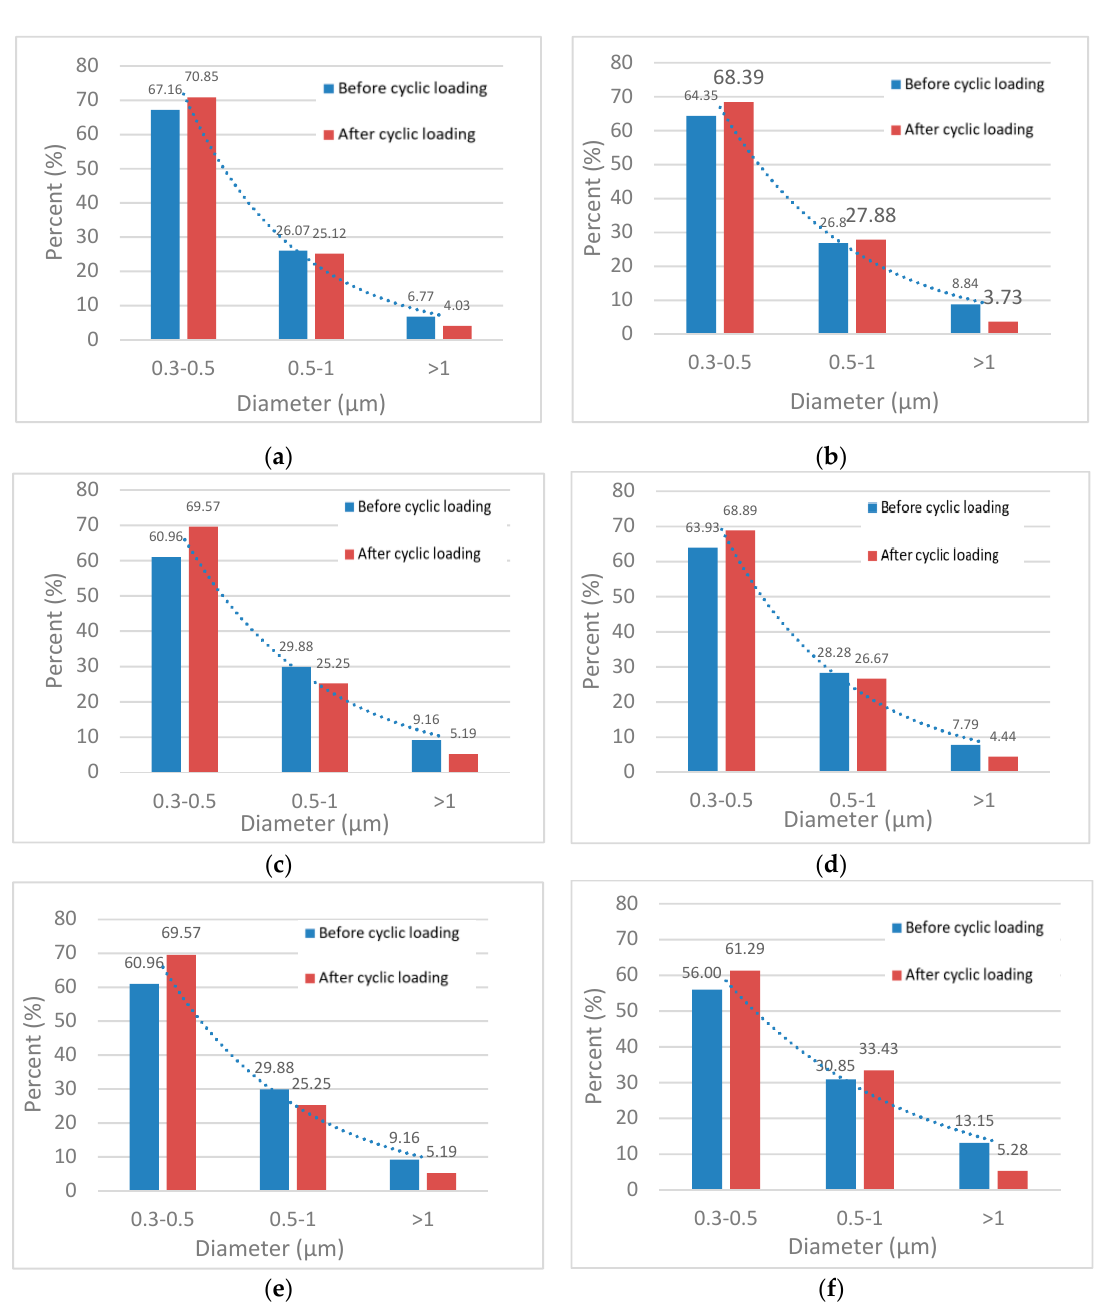
Figure 17. Distribution of effective pore size for ( a ) first-cycle frozen soil after cyclic loading at − 10 °C; ( b ) second-cycle frozen soil after cyclic loading at − 10 °C; ( c ) first-cycle frozen soil after cyclic loading at − 20 °C; ( d ) second-cycle frozen soil after cyclic loading at − 20 °C; ( e ) first-cycle frozen soil after cyclic loading at − 30 °C; ( f ) second-cycle frozen soil after cyclic loading at − 30 °C.